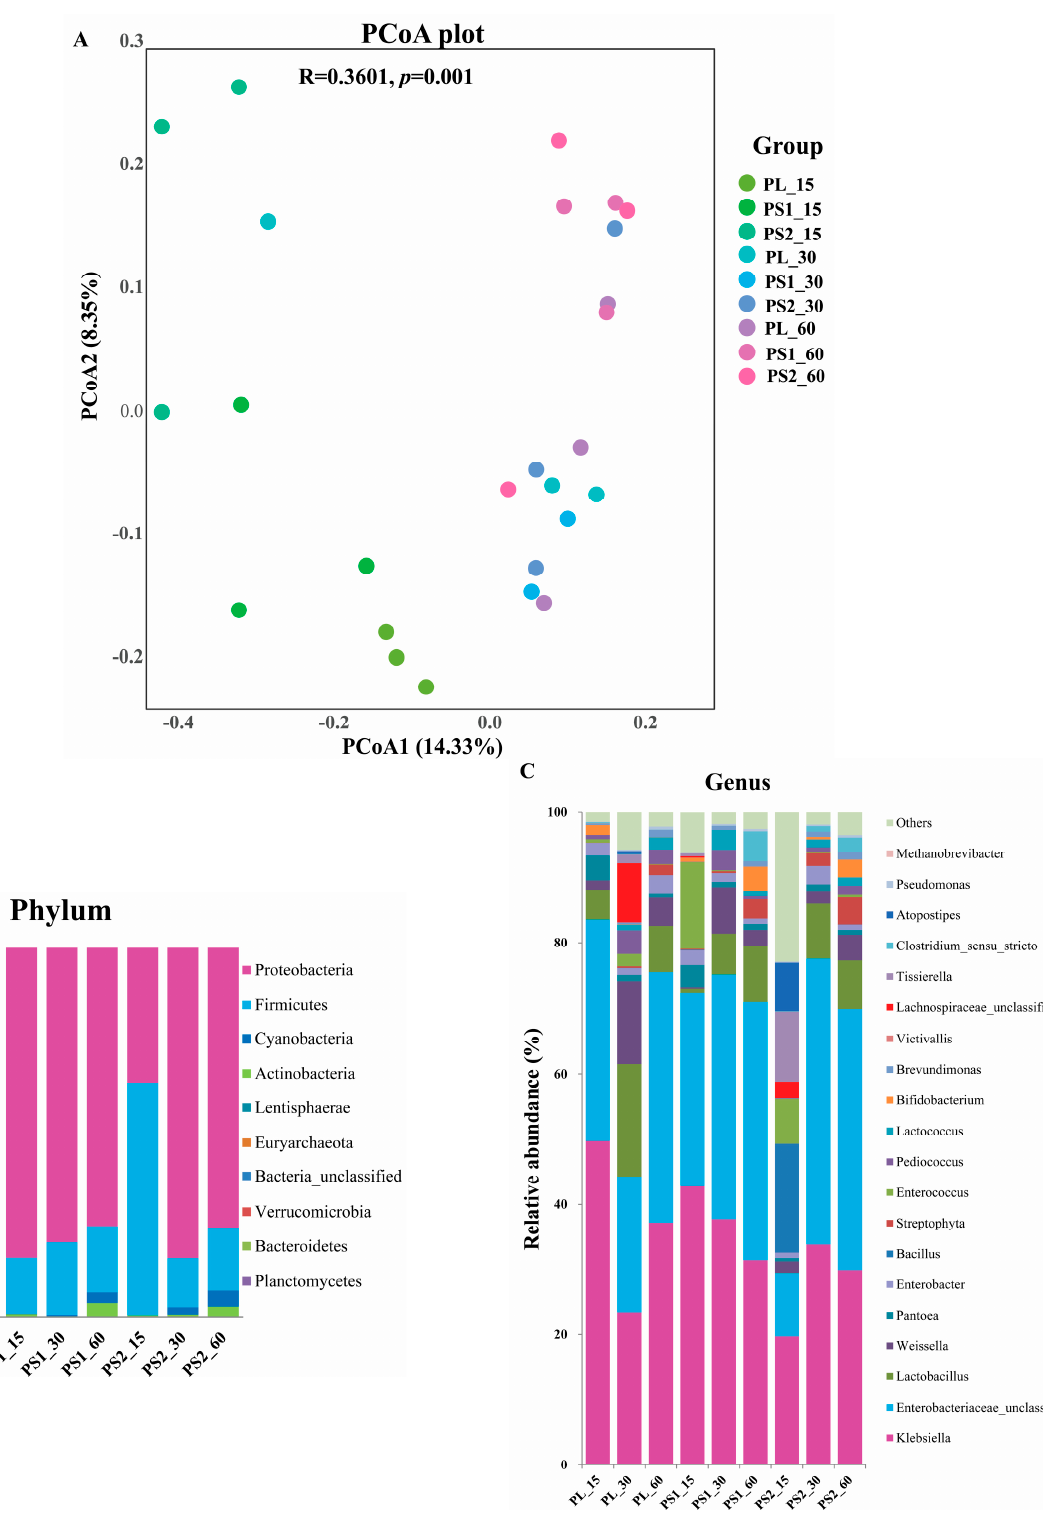
Figure 1. ( A ) Principal coordinate analysis (PCoA). ( B ) Relative abundance of the microbiota at the phylum level in the kudzu silage samples. ( C ) Relative abundance of the microbiota at the genus